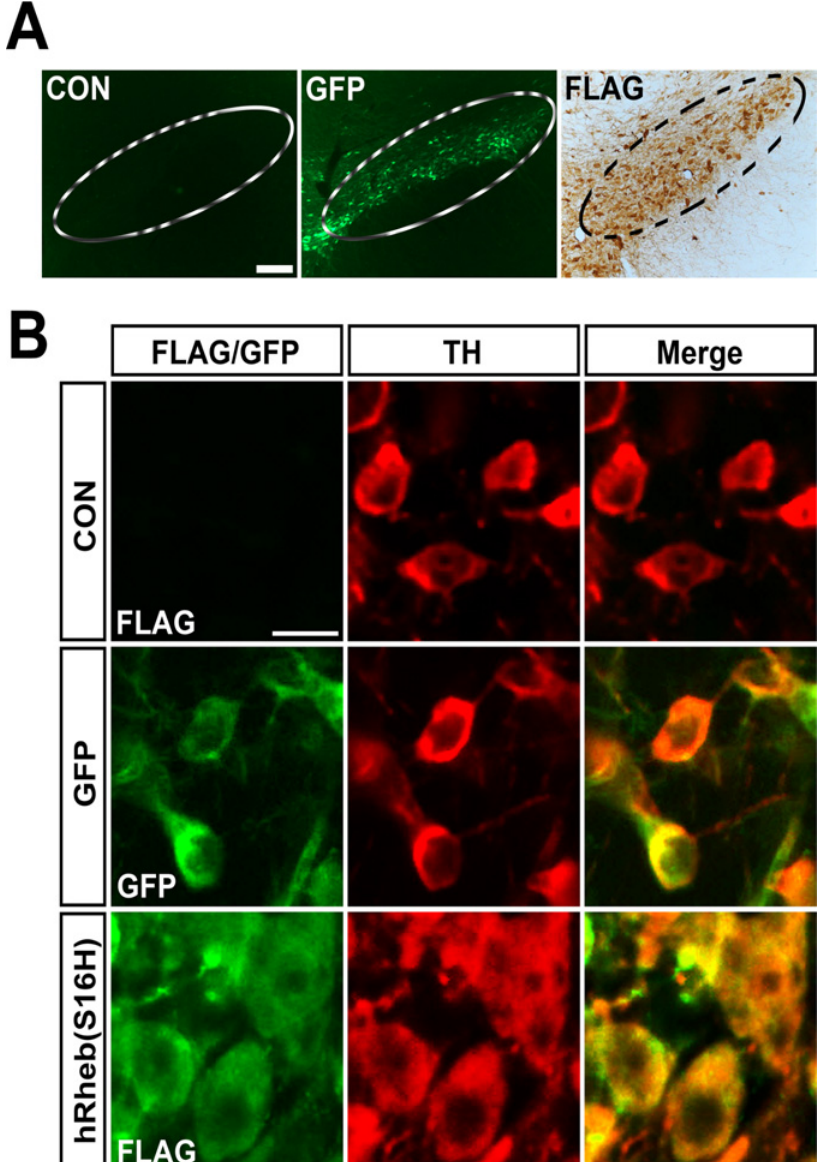
Fig 1. hRheb(S16H) transduction in SNpc of normal adult rats (A) Animals received a unilateral injection of AAV-GFP or AAV-hRheb(S16) in the SN and sacrificed 4 weeks later. AAV-hRheb(S16H)-treated sections were immunolabeled with FLAG. No expression was found in the non-injected control side (CON), but expression of GFP and FLAG by each viral vector injection is found in the ipsilateral side of SNpc of normal brains. Inside areas of the dotted lines indicate the SNpc. Scale bars, 200 μ m. (B) Immunofluorescence double labeling for GFP (green) and TH (red), or FLAG (green) and TH shows that transgene expression is identifiable within dopaminergic neurons in the SN. Scale bar, 20 μ m (n = 4, each